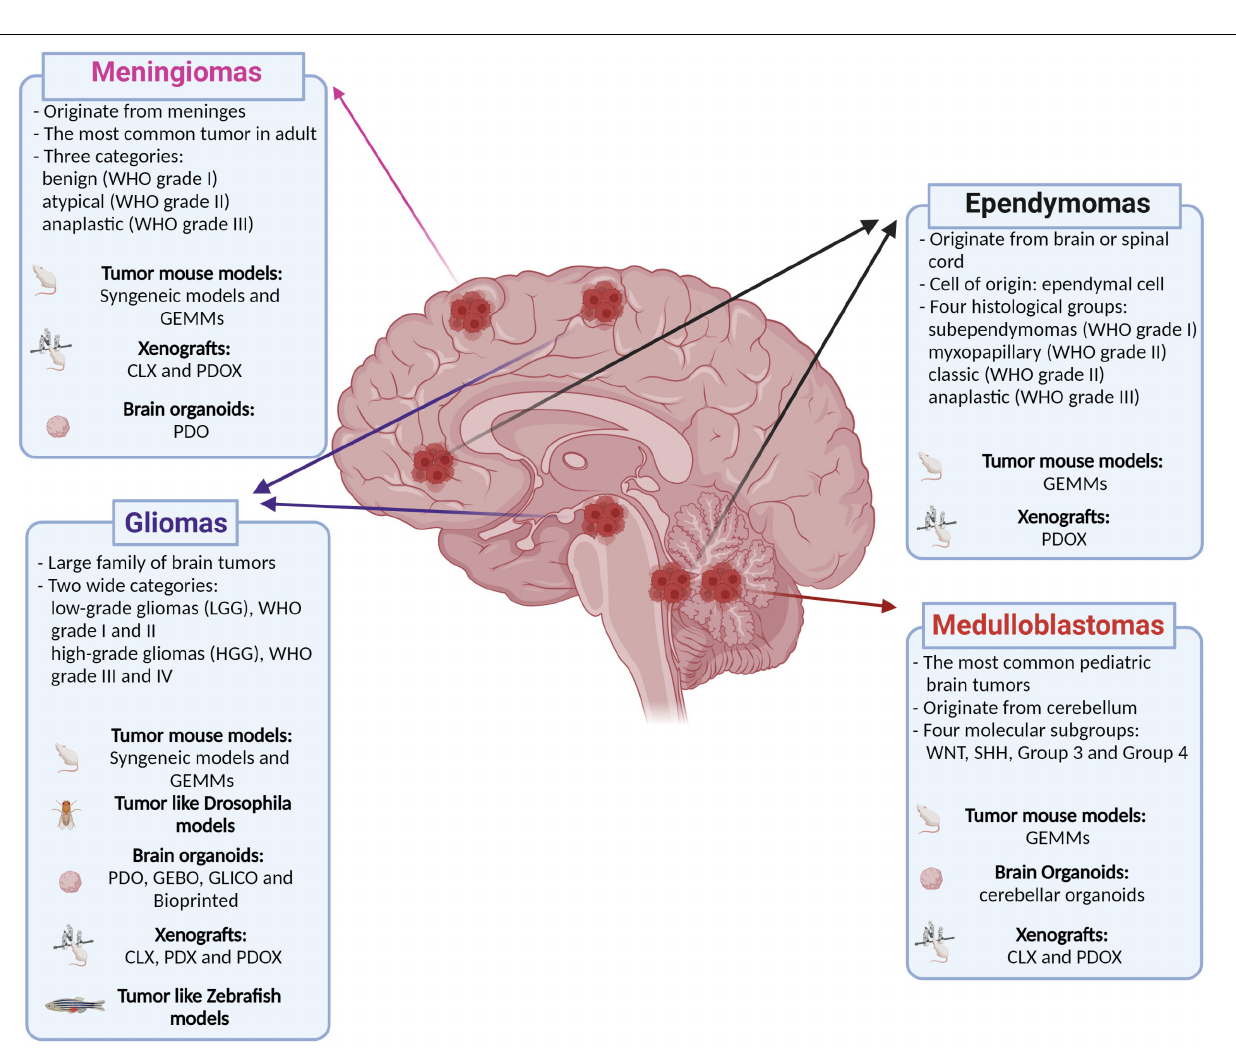
Frontiers in Molecular Neuroscience |